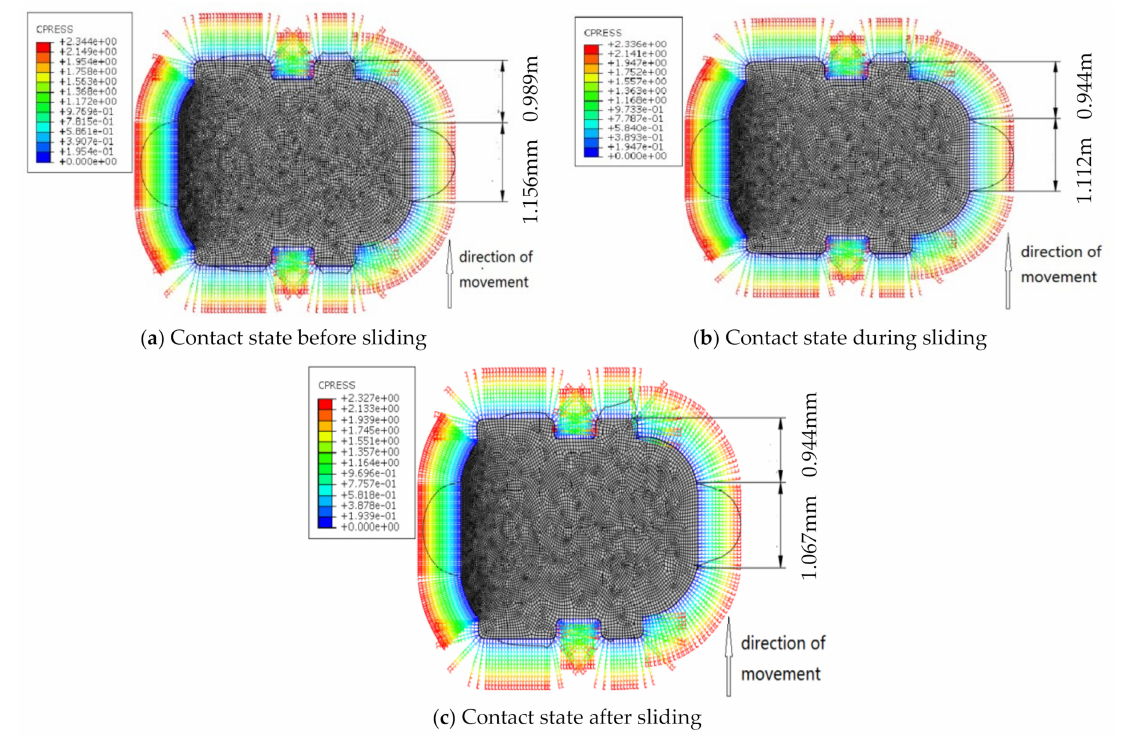
Figure 13. Stress diagram of seal ring simulation friction process. Then, the contact widths at all positions of the cylinder were fitted into friction forces. Figure 14 shows the frictional forces under the angles of the cylinder, which represent the circumference variables in the test point. Results indicate that the predicted friction force was dependent on the measured results; the contact width in the sliding process was less than that in the static state of the cylinder.